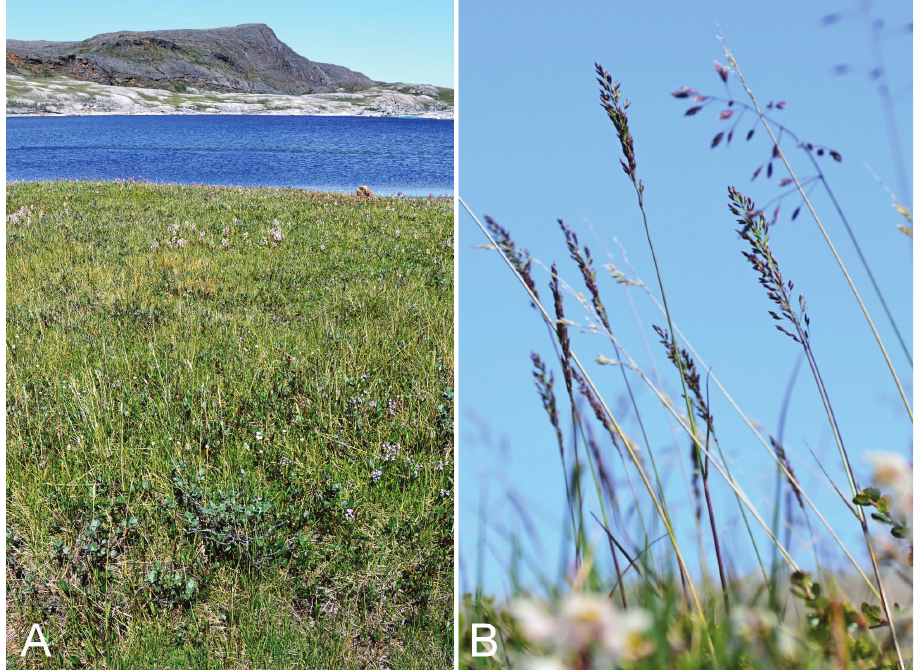
Figure 7. Calamagrostis stricta subsp. groenlandica : A habitat B habit, Saarela et al. 2576 . Photographs by R.D.